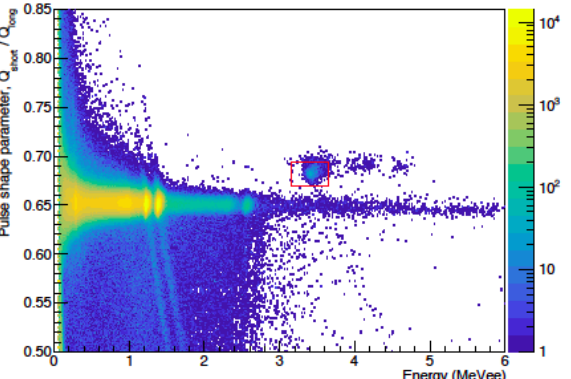
Figure 5: PSP parameter vs light output foe the CCLB detector in a 15kHz gamma